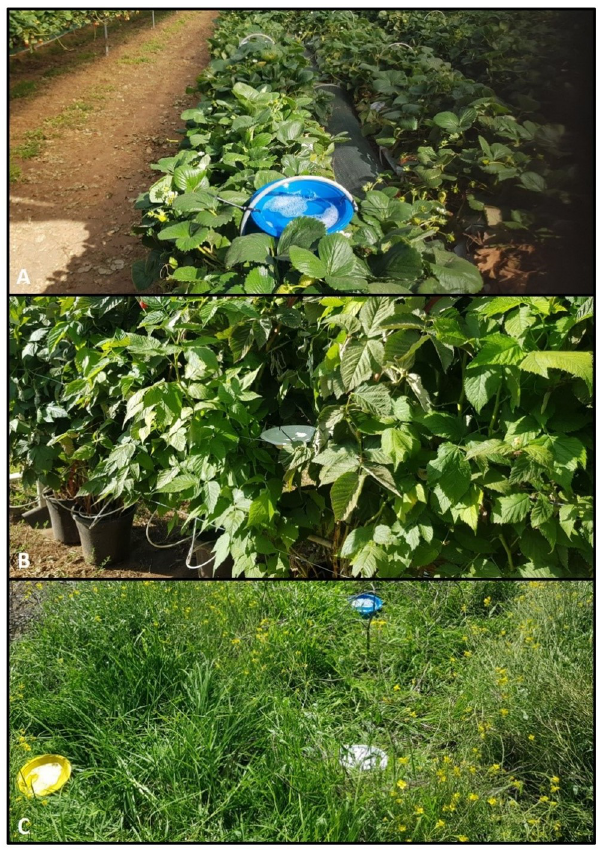
Fig 2. Pan-trap locations. (A) Strawberry polytunnel, (B) raspberry polytunnel, (C) open weed area. A blue, yellow, and white pan-trap were placed in each location to allow for known impacts of colour on insect counts of different species